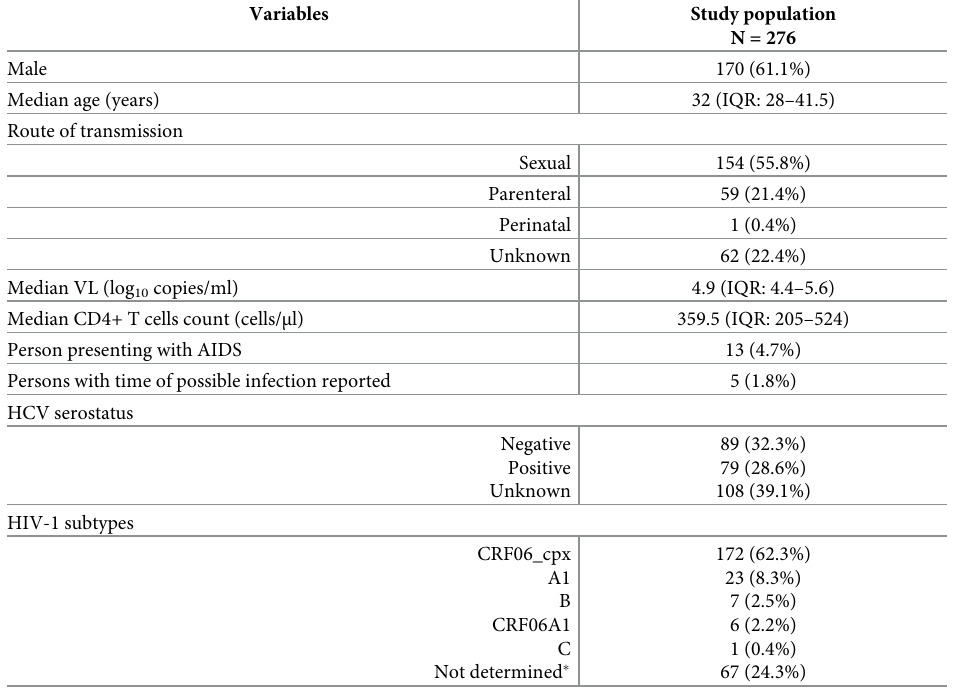
Table 1. Characteristics of the Estonian study population tested by the incidence